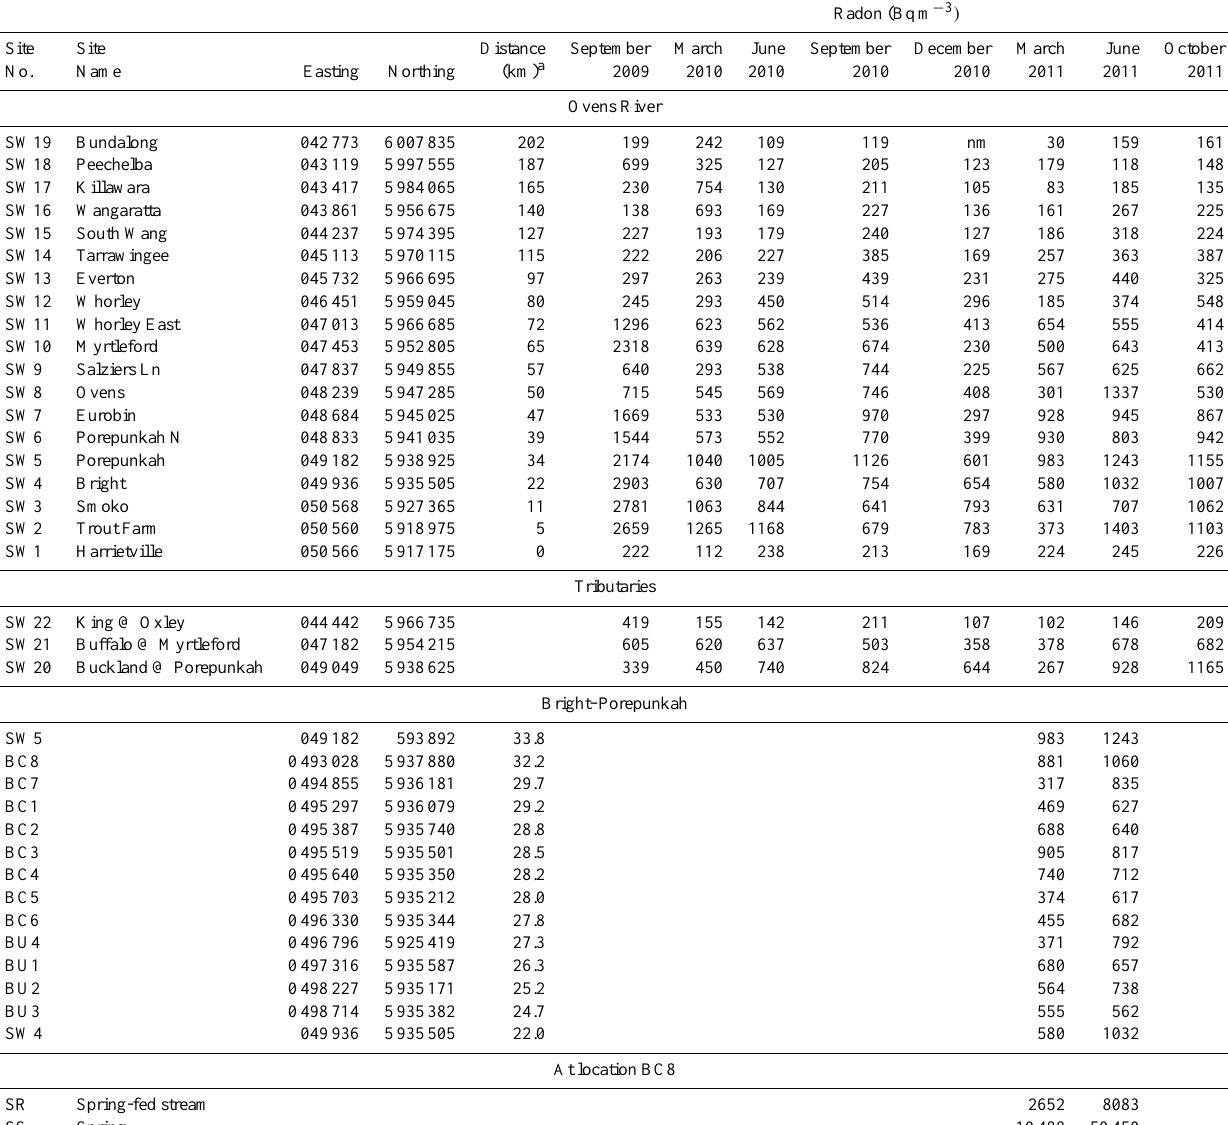
Table 4. 222 Rn activities of the Ovens